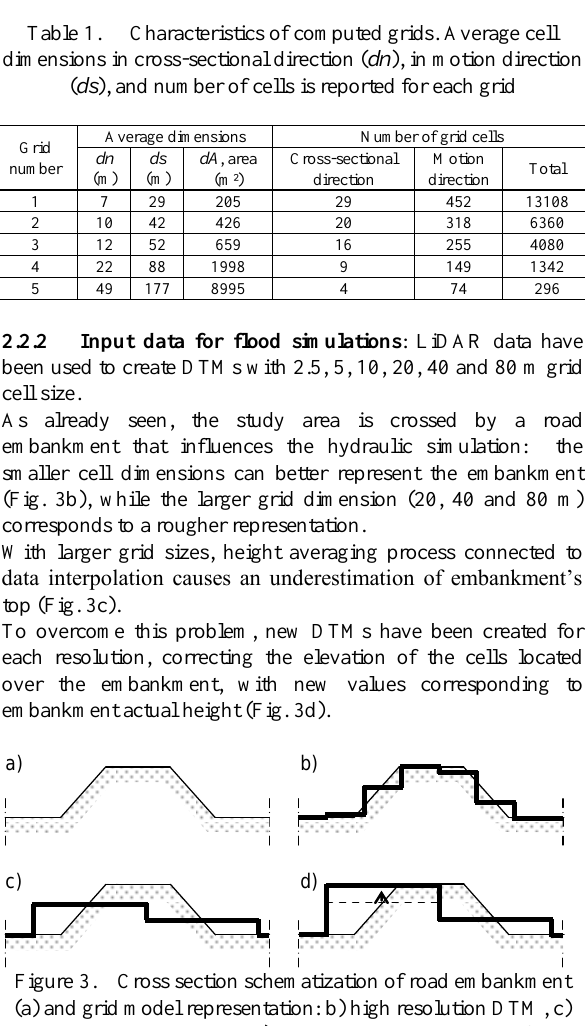
Figure 2. Curvilinear grids constructed with different cell dimensions. Grid order is shown according to refinement